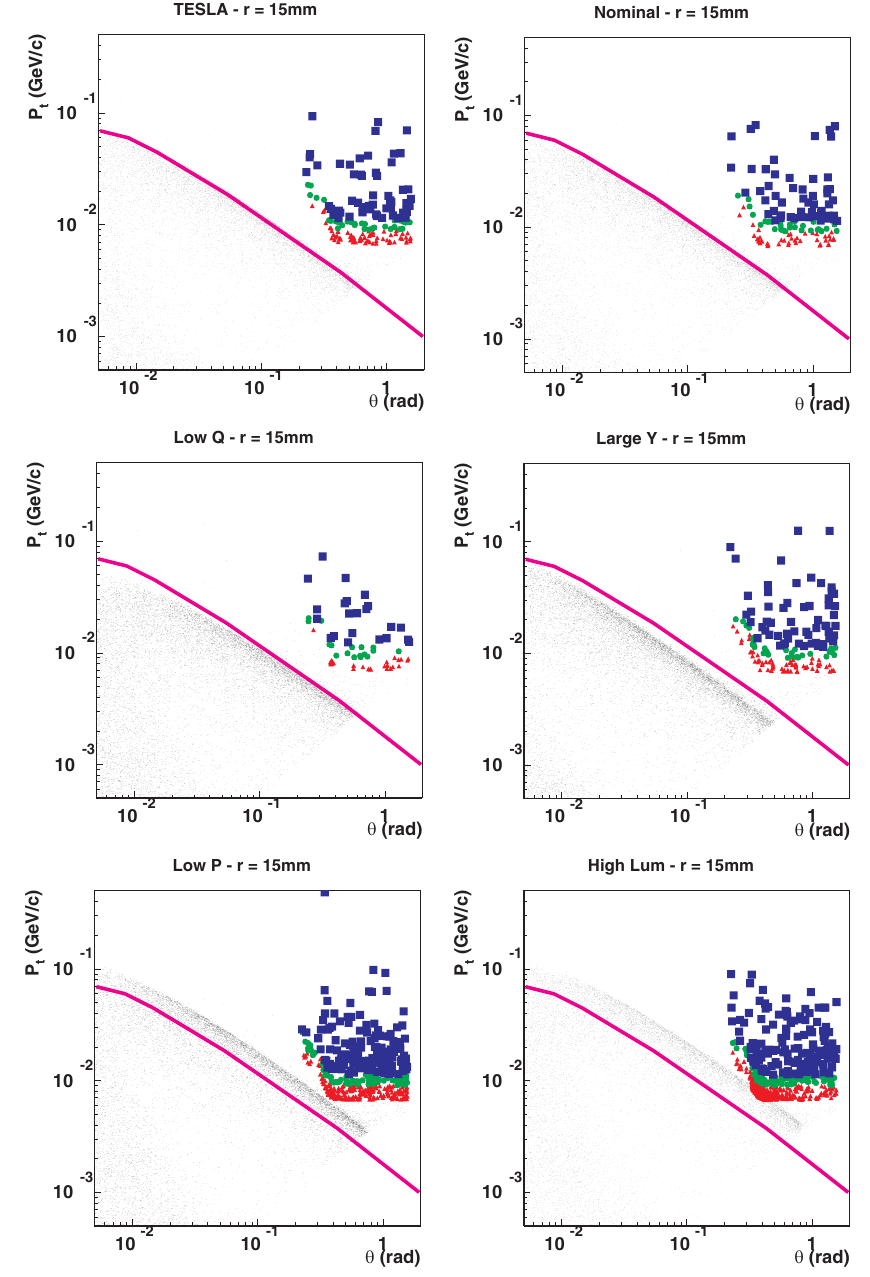
(cid:7) 15 mm . The black points are all the IPC 1